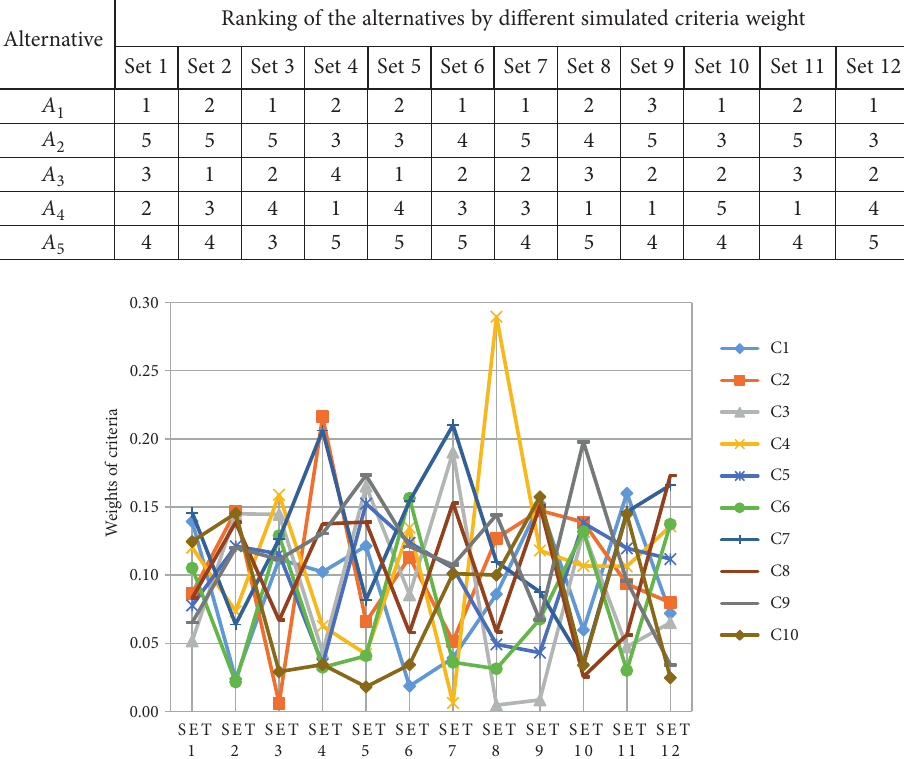
Table 13. Supplier alternatives ranking for different sets of criteria weight